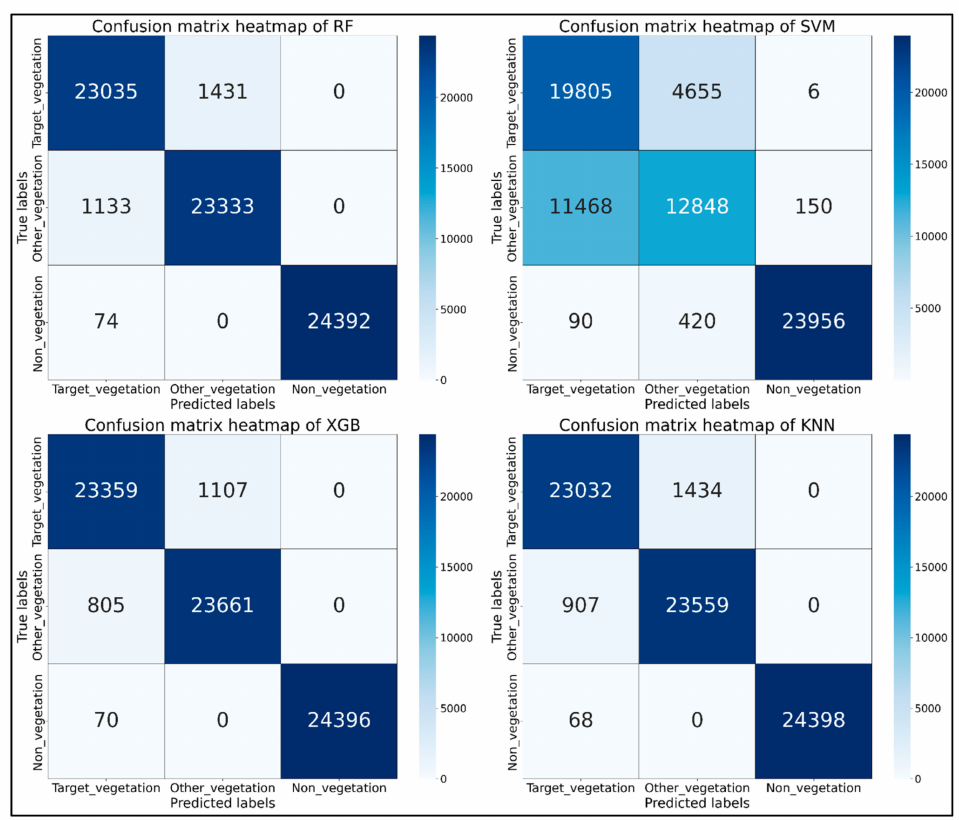
Figure 14. Confusion matrix for validation of different machine learning models for foliage